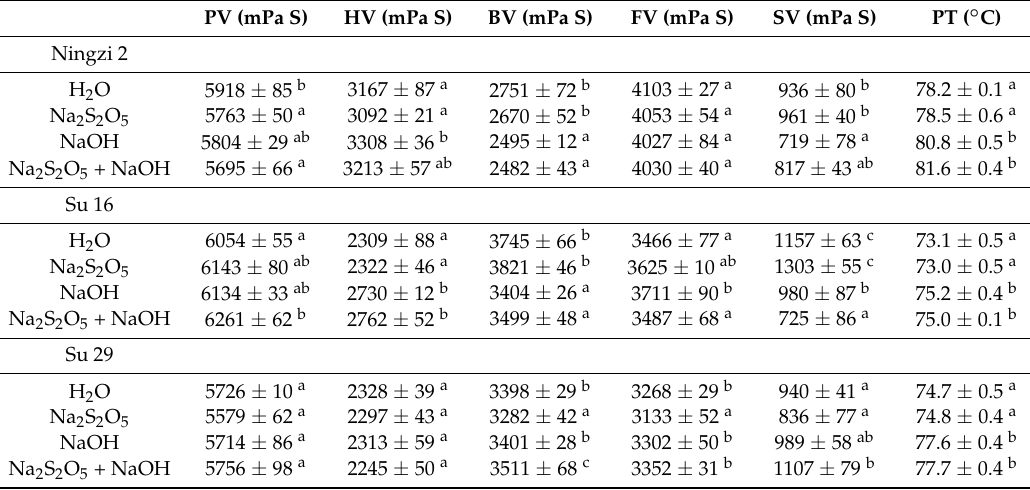
Table 6. Pasting parameters of starches.